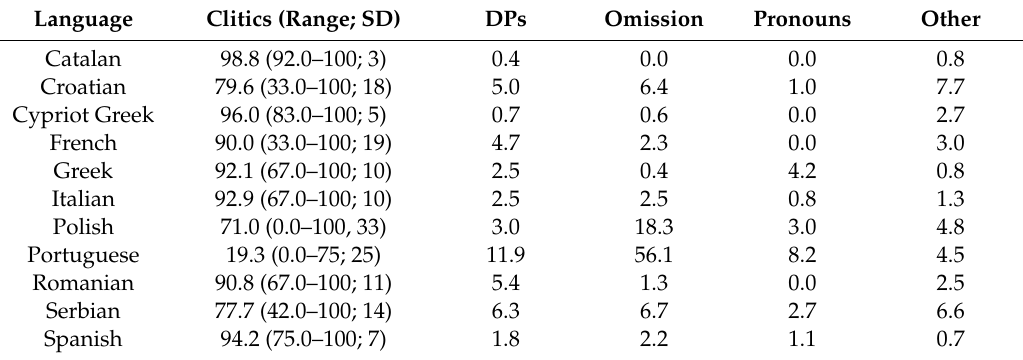
Table 6. Distribution of objects in five-year-olds; table taken from Varlokosta et al. (2016, p. 13). Language Clitics (Range; SD) DPs